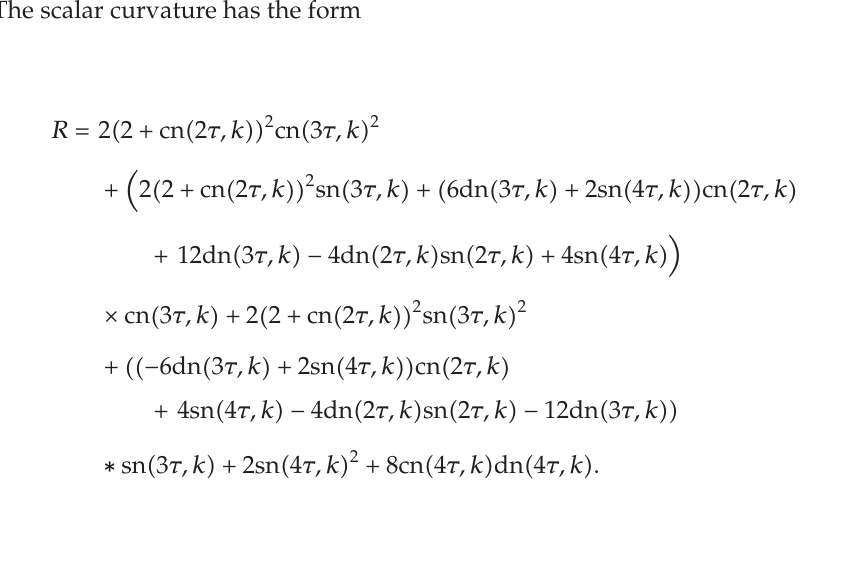
The scalar curvature has the